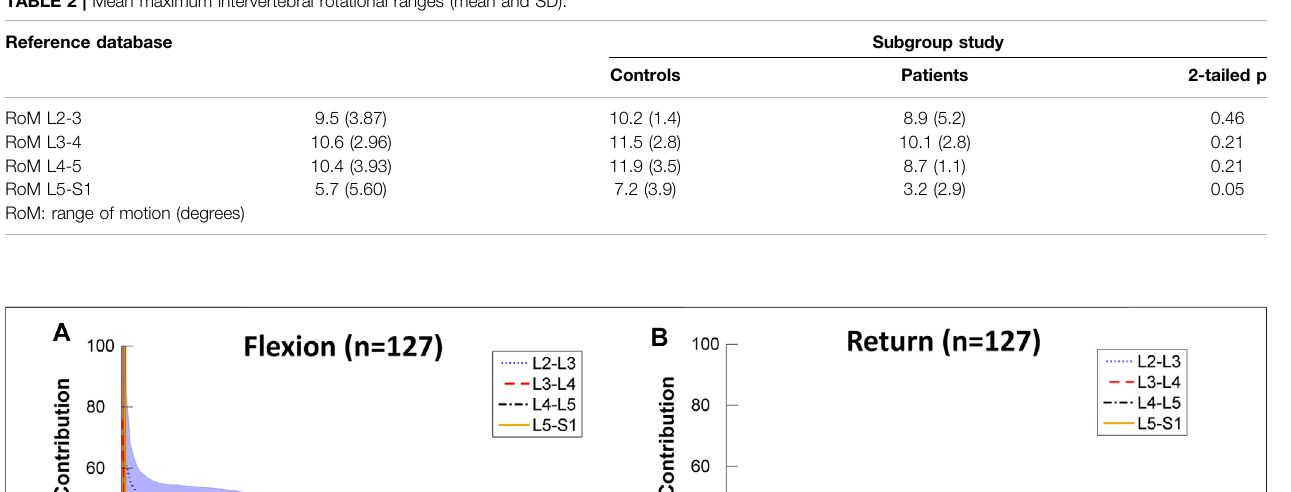
TABLE 2 | Mean maximum intervertebral rotational ranges (mean and SD).